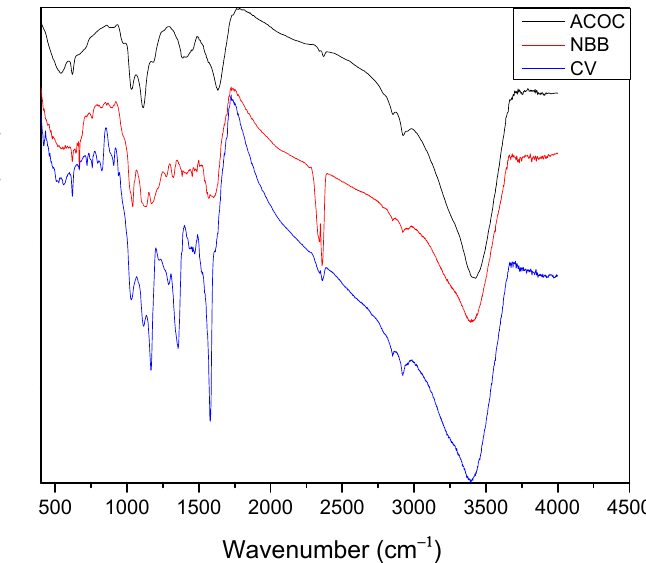
Figure 2. IR spectra of ACOC, ACOC after adsorption of NBB and ACOC after adsorption of CV.